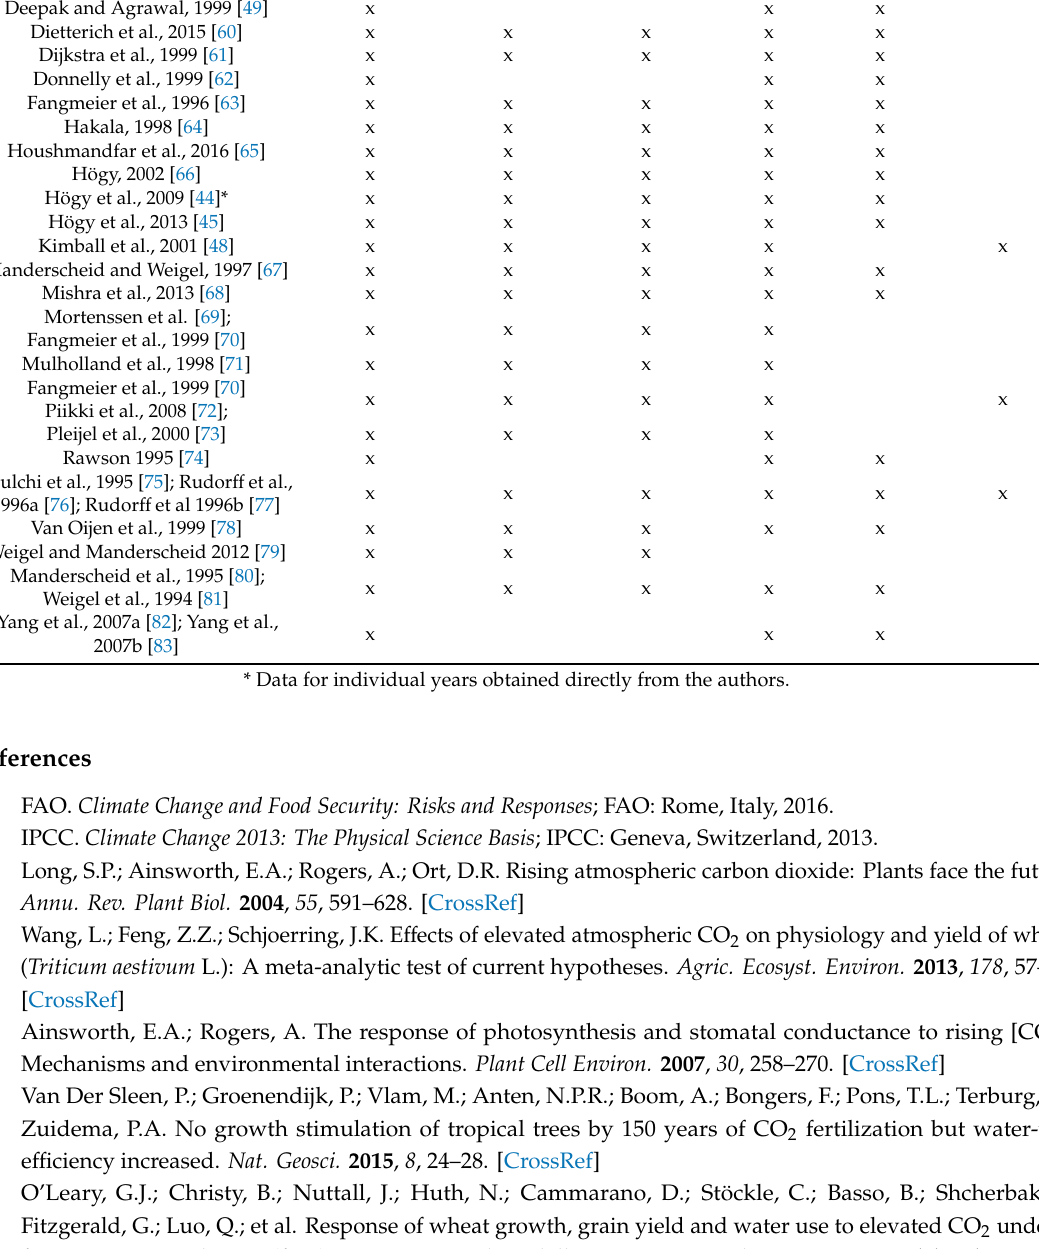
Table A1. References for data sources used in the analysis, database in the Supplementary Materials file.